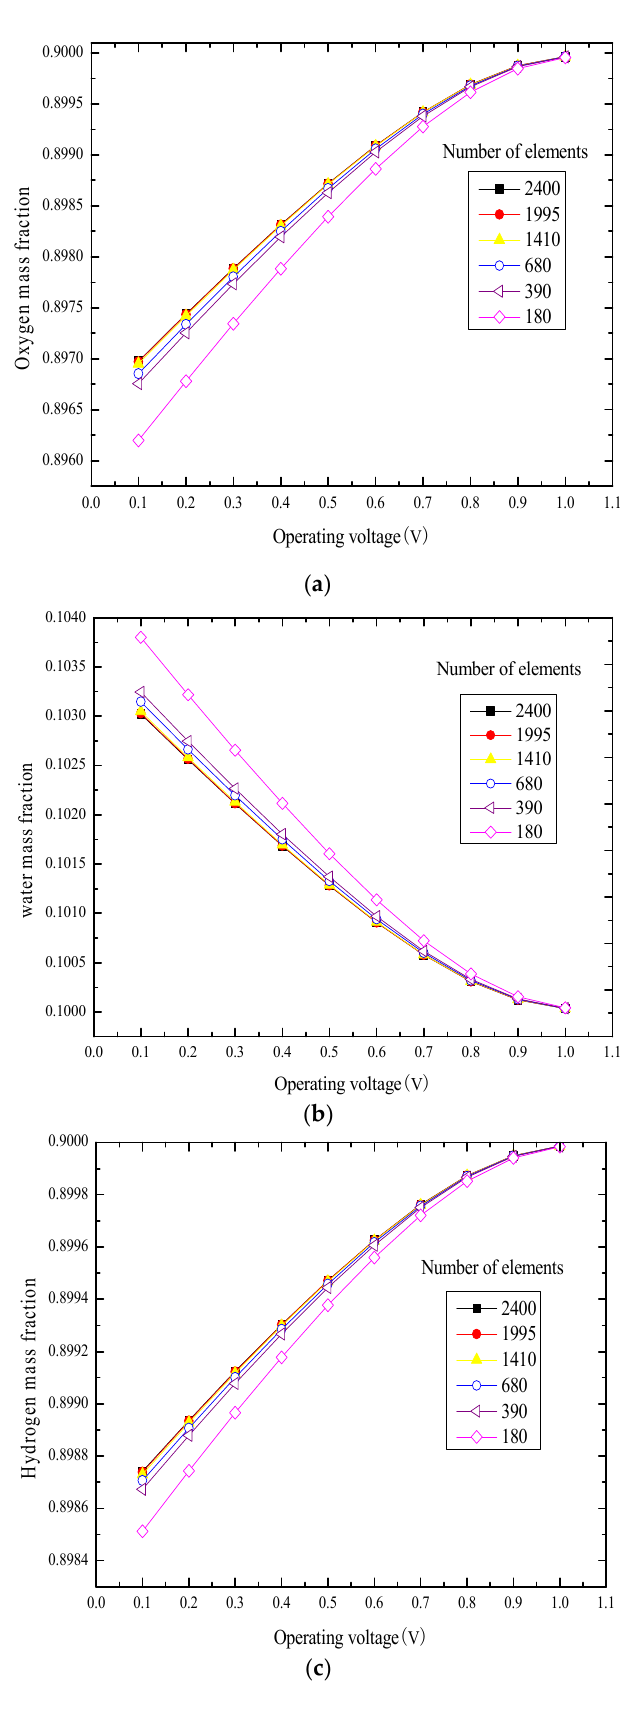
Figure 2. Element independence test for the present mode. ( a ) O 2 mass fraction; ( b ) O 2 side H 2 O mass fraction; ( c ) H 2 mass fraction.